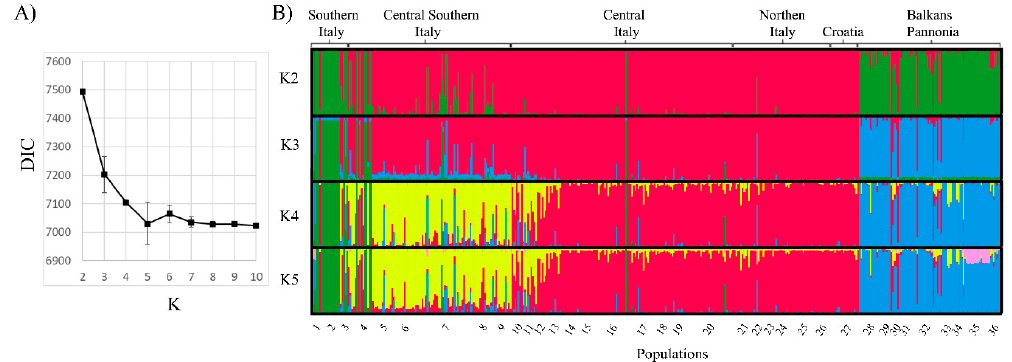
Figure 4. TESS analysis considering a no-admixture model. ( A ) Values of DIC in relation to the values of K. ( B ) Bar plots. Each individual is represented by vertical columns and the proportions of each K are represented by different colors. Populations and their geographic origin are given below and above the figure, respectively.